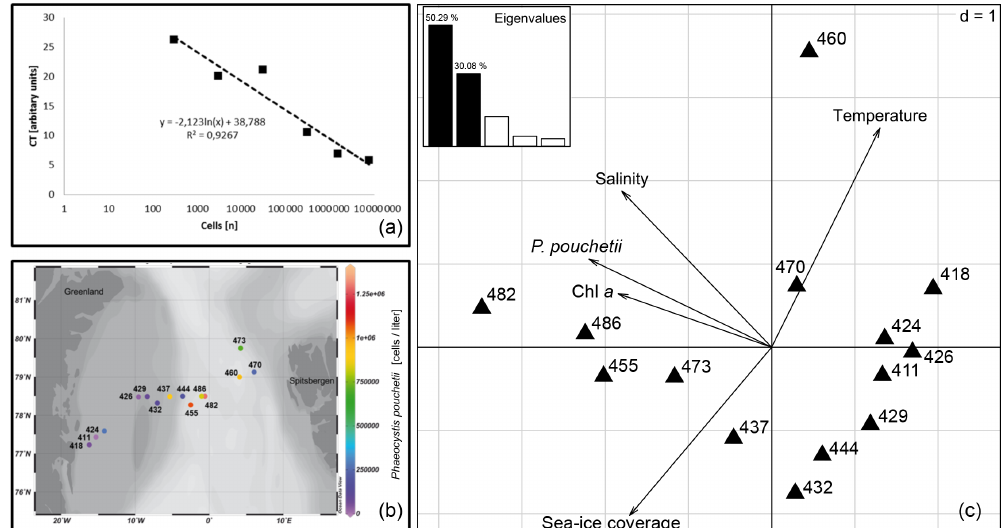
Figure 4. Assessment of Phaeocystis pouchetii in the Fram Strait. (a) Calibration of Phaeocystis pouchetii -specific qPCR assay with a dilu- tion series of laboratory cultures. The CT value is significantly correlated with cell numbers. (b) Abundance of Phaeocystis pouchetii in the Fram Strait. The dots and the associated numbers represent sampling sites and associated station numbers of expedition ARKXXVIII(PS85) of RV Polarstern in summer 2014, while cell numbers/liter are reflected by different colors. (c) Principal component analysis including en- vironmental parameters (temperature, salinity, Chl a biomass, and sea-ice coverage) and abundance of Phaeocystis pouchetii . Triangles and associated numbers represent sampling sites and associated station numbers of expedition ARKXXVIII (PS85) of RV Polarstern in summer 2014. HG4 indicates the central station of the deep-sea long-term observatory Hausgarten in the Fram Strait. The eigenvalues indicate the proportion of variance explained by different dimensions in the diagram. The black bars in the histogram reflect the x axis and the y axis. Here ∼ 80% of variance is explained in this two-dimensional diagram of the PCA ( x axis: 50.29%; y axis: